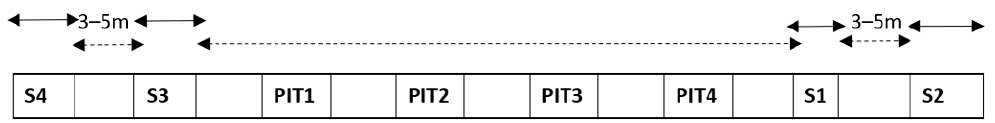
Figure 3. The sampling locations of the carbon in snow experiment (Spots S1–S4), and the locations of the four snow pits (Pits 1–4) used for other snow chemistry studies in Kolm Saigurn, Austria. The width of the sampling spot number 1 (S1) was one meter. The width of the sampling spots 2–4 (S2–S4) was two meters. The space between the sampling spots was approximately 3–5 m. The distance from S2 to S4 was approximately 30–50 m.